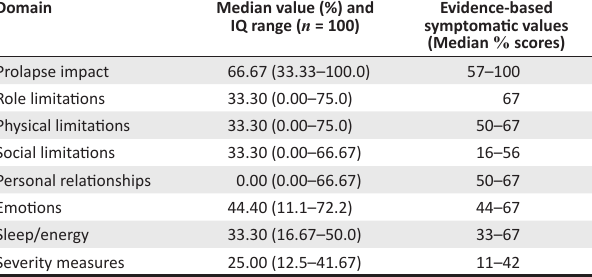
TABLE 2: Table of median domain scores of the prolapse-quality of life questionnaire preoperatively, n = 100. Domain